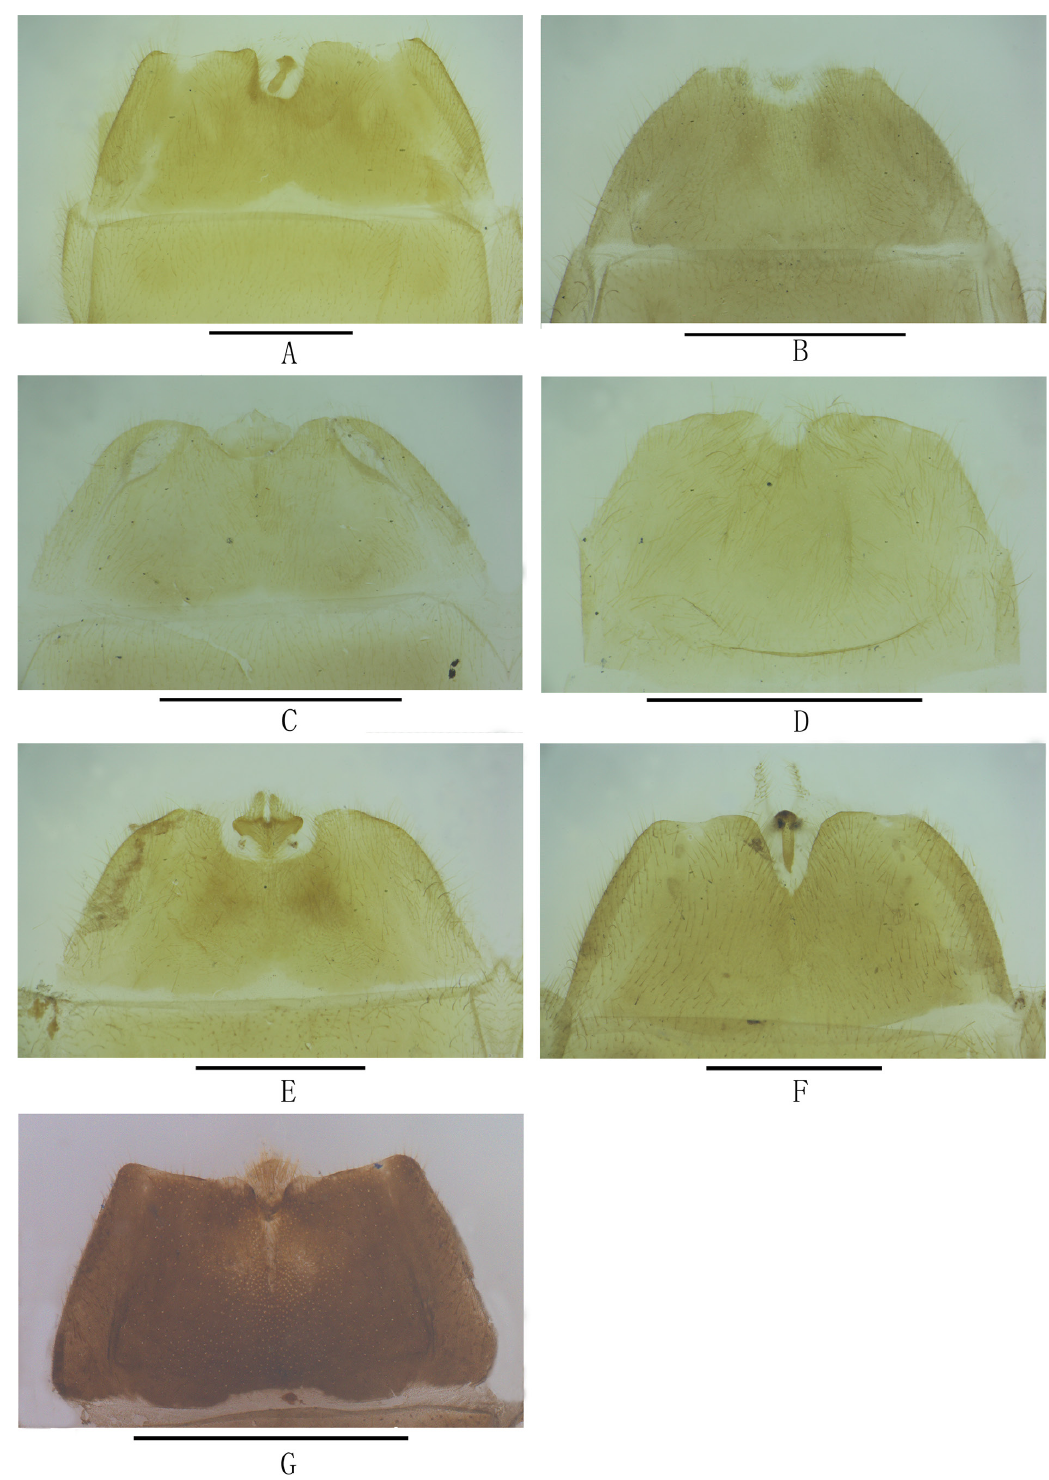
Fig. 8. Female abdominal sternite VIII, ventral view. A . Stenothemus biimpressiceps (Pic,